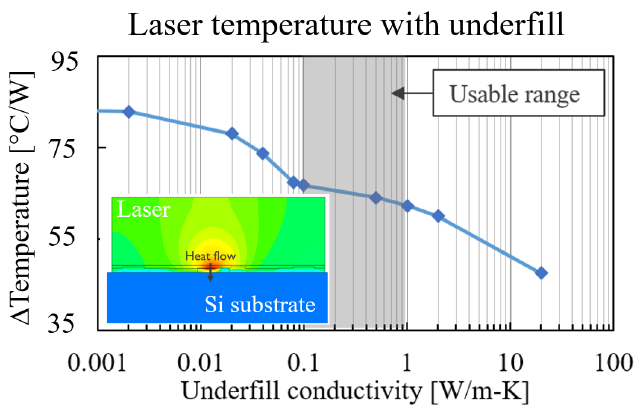
Figure 15. Laser temperature rise vs. underfill thermal conductivity. Insert shows the temperature contour plot and heat flux through the underfill into the Si